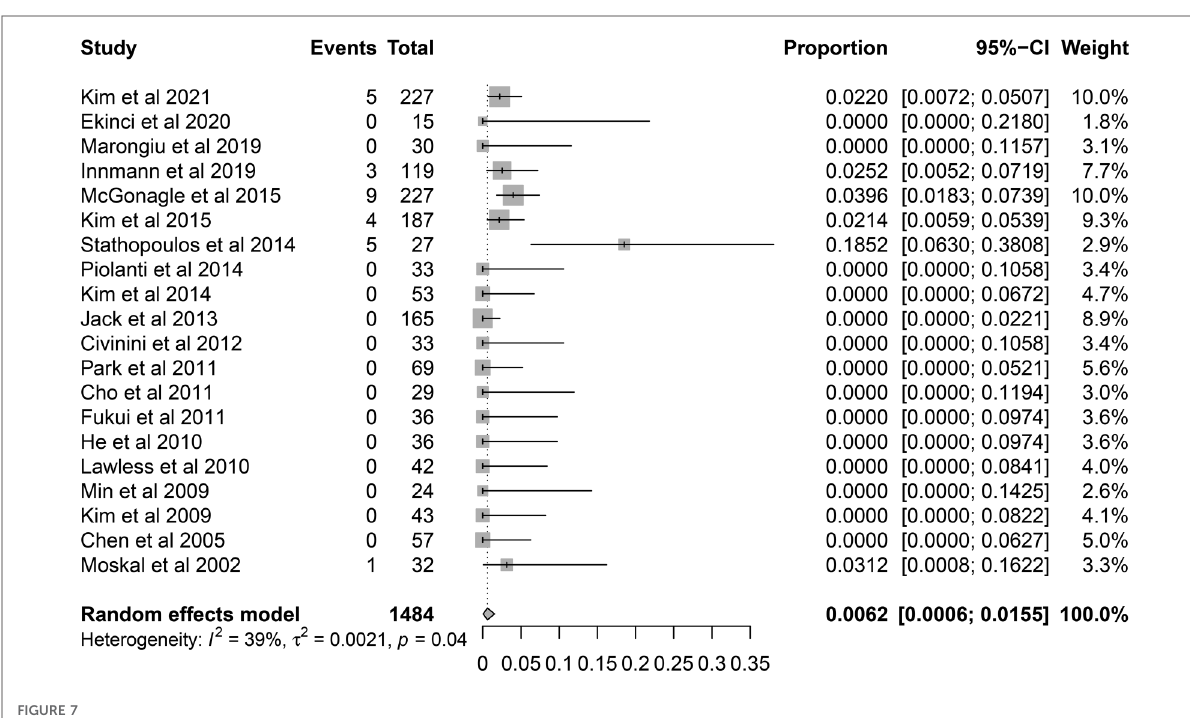
FIGURE 7 Forest plot for the re-revision rate of retained stems for aseptic loosening.